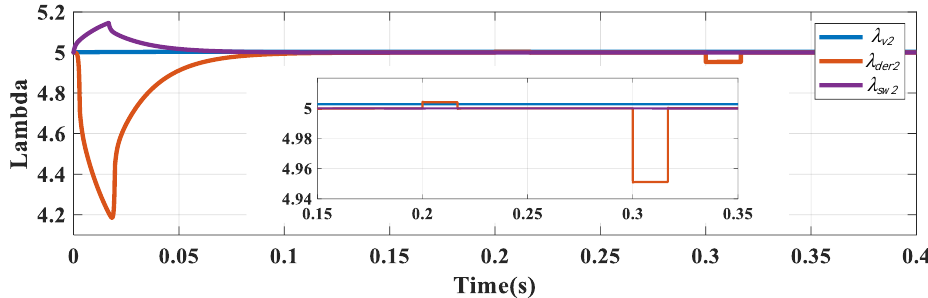
Figure 10. Study 1: generated weighting coefficients for FCS-MPC in DG2.